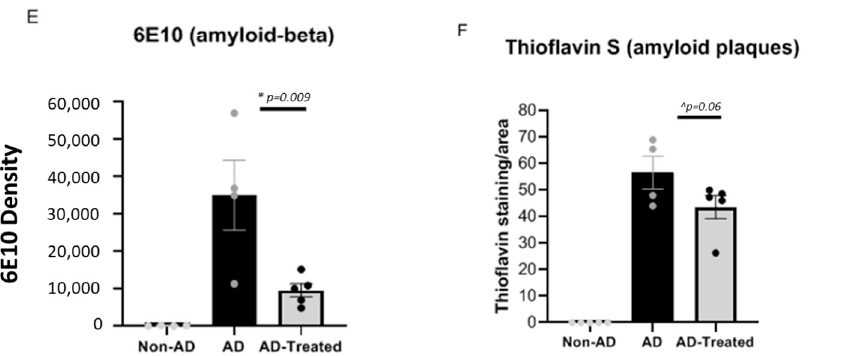
Figure 2. Reduced neuronal damage and amyloid burden in the cortex of AD mice treated with mitochondrial transfer. ( A ) NeuN and FJC staining of neurons. Lower neuronal count (NeuN) (relative to non-AD mice) and presence of degenerative neurons (FJC) were detected in the AD mice, with increased neural counts and decreased degenerative neurons in mitochondria-treated AD mice relative to untreated AD mice. ( B , C ) Quantitative analysis: one-way ANOVA showed a significant difference between the groups [f(2, 12) = 12.59, p = 0.001]. LSD post-hoc analysis showed a significantly lower neuronal count in AD vs. non-AD mice ( p = 0.0003), with higher count in mitochondria-treated vs. untreated AD mice ( p = 0.04) and a trend toward decrease in degenerative neurons in the treated vs. untreated AD mice ( t -test, p = 0.1). ( D ) 6E10 and thioflavin staining for amyloid. Amyloid pathology was detected in AD mice. Decreased amyloid pathology in the mitochondria-treated relative to untreated AD mice. ( E , F ) Quantitative analysis: lower amy- loid burden (6E10) and plaques (thioflavin) in mitochondria-treated vs. untreated AD mice ( t -test, p = 0.009; trend, p = 0.06, respectively). Staining of 6E10 and thioflavin was hardly detected in the non-AD mice (* statistically significant; ˆ